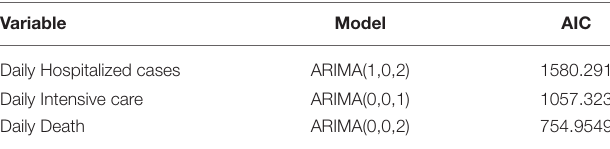
TABLE 4 | Best-fit models and quality